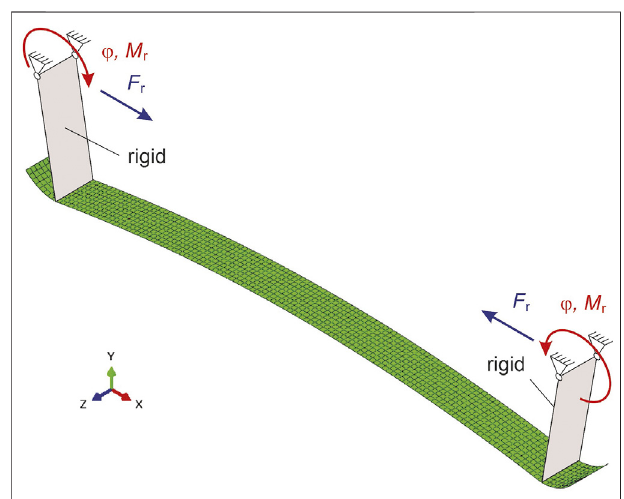
FIGURE 2 | Finite element model of the axle